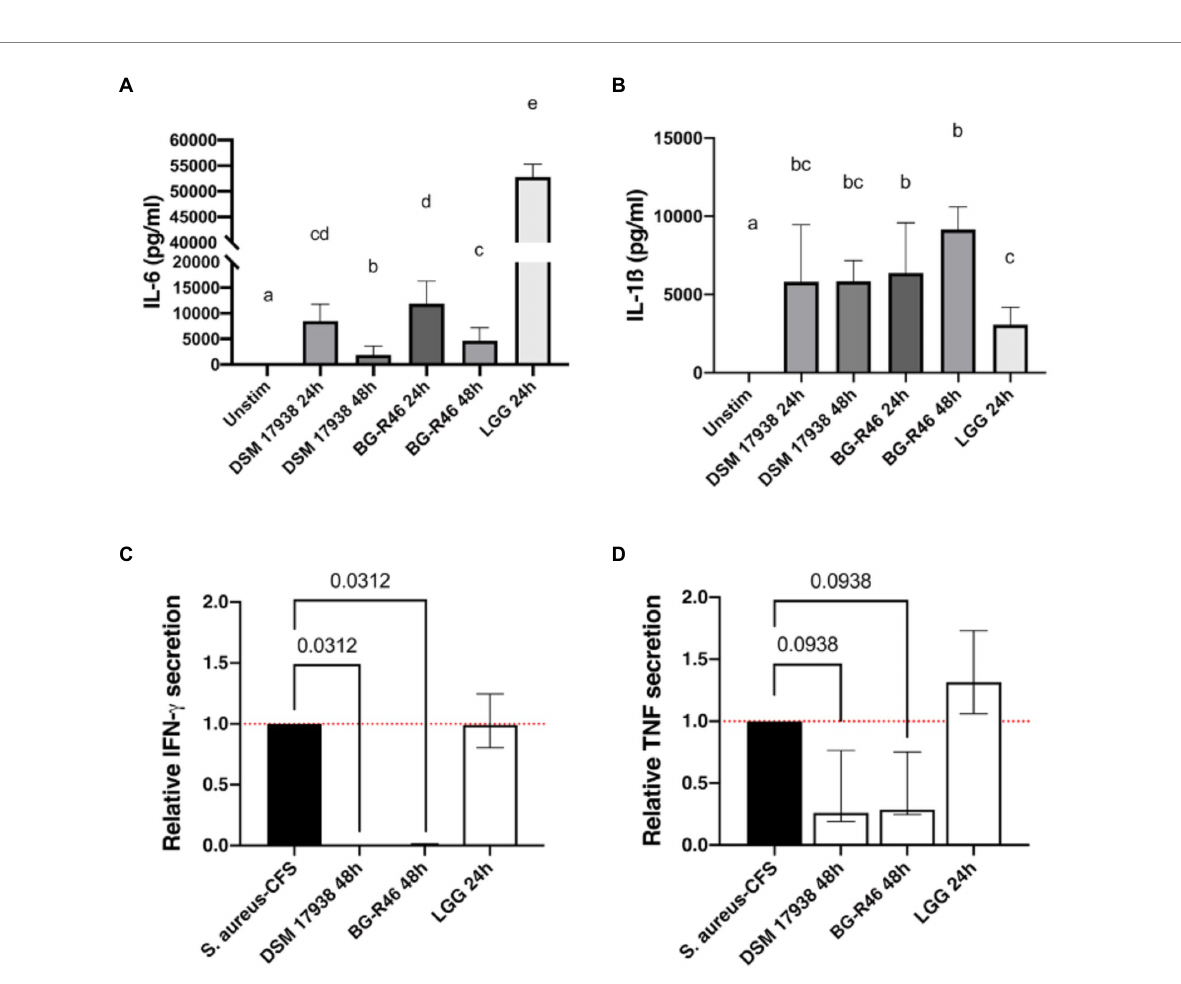
FIGURE 7 Immunomodulatory effects of L. reuteri DSM 17938, BG-R46 and LGG derived MV in PBMC. Secretion of cytokines IL-6 (A) and IL-1 β (B) in naïve PBMC after incubation with MV derived from DSM 17938, BG-R46 and LGG. PBMC were cultured with MV for 48 h before quantification. Bar plots show median with interquartile range. Bars with different letters are significantly different ( p <0.05). Statistical analysis by Mann–Whitney test, n = 6. Relative secretion of IFN- γ (C) and TNF- α (D) in S. aureus stimulated-PBMC in response to incubation with MV derived from L. reuteri DSM 17938 and BG-R46 and LGG. PBMC were cultured with MV for 48 h before quantification. Quantification of IFN- γ and TNF- α levels from PBMC stimulated with S. aureus were set to 1. Statistical analysis by Wilcoxon matched pairs signed rank test, n = 6.